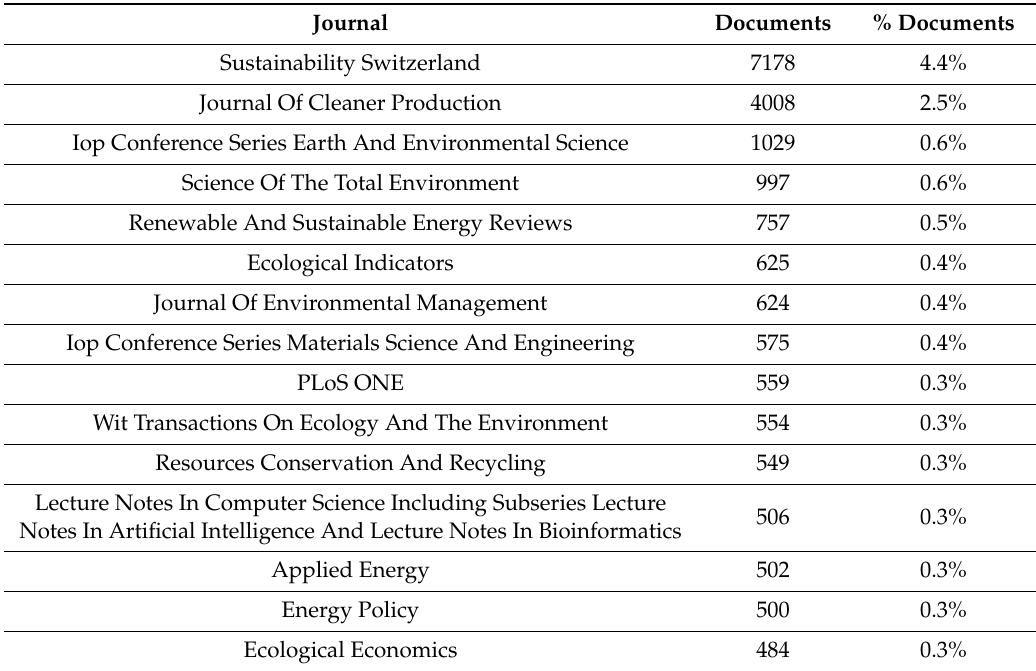
Table 2. Journals on sustainability between 2011 and